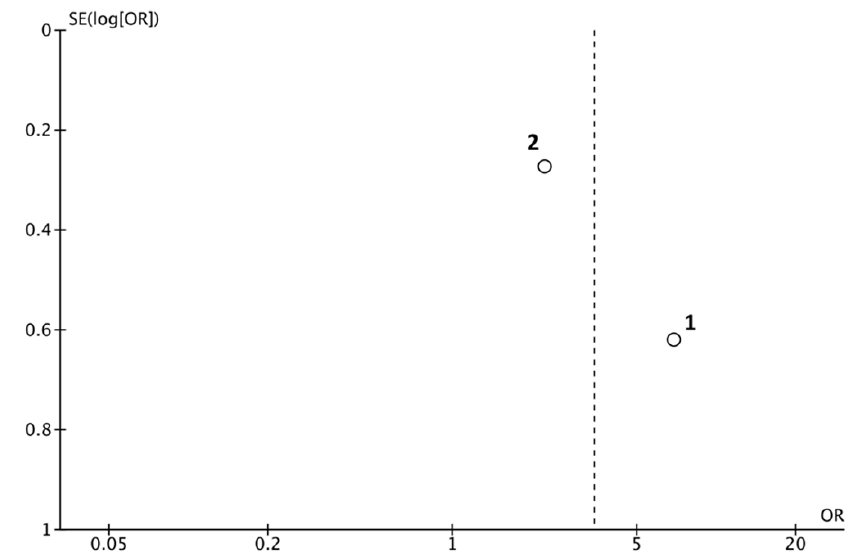
Figure 3. Forest plot of ORs and 95% confidence limits (CL) for the comparison of smokers and healthy control subjects regarding the frequency of extracted root-filled teeth (RFT). Overall estimate is based on data from the two studies. Black squares represent the point estimate of the odds ratio and have areas proportional to study size. Lines represent 95% confidence intervals. The diamond shows the summary statistic for the two studies. The solid line indicates an odds ratio of 1.0, and the dashed line indicates the overall odds ratio. OR: odds ratio; LCL: lower confidence level; UCL: upper confidence level. 3.3. Interpretation and Assessment of the Included Studies The two studies included in the meta-analysis are retrospective, being published in 2007 [43] and 2017 [42]. With the results of the two studies, data from 516 RFT, 351 non-smokers, and 165 smokers were collected. In the study of Doyle et al. [43], the information from 367 patient’s charts was collected for a period of time of 10 years and clinical data, number of RFT, periapical index of RFT, patient’s habits, and type of restorations were determined. A positive association between smoking habits and the extraction of RFT was found. Smokers showed significantly higher percentage of extracted RFT (18.4%) compared with non-smokers (3.2%) (OR = 6.91; 95% CI = 2.06– 23.19; p = 0.00043). The second study, Khalighinejad et al. [42], classified RFT according to their periodontal status and in addition also collected personal data. Nine years after, the authors evaluated teeth that required extraction and the factors that were related to this. The outcome revealed an increased risk